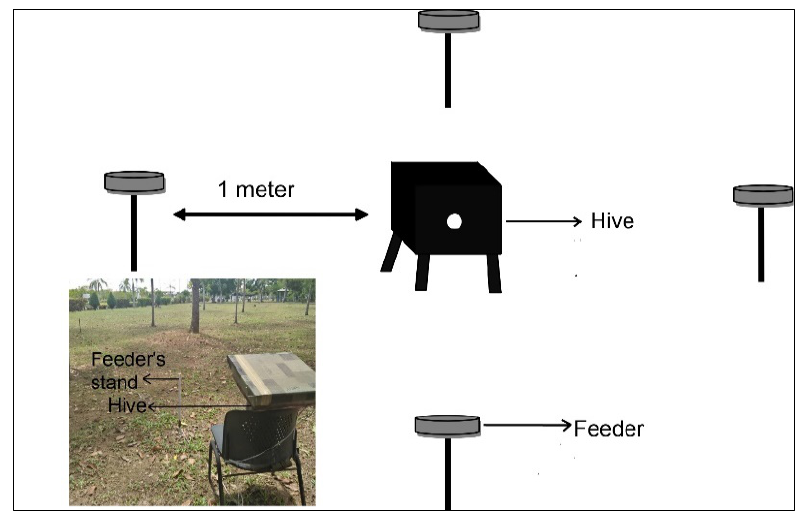
Figure 1. The experimental set-up for experiment 1. The set-up was a modified version from Ciar et al. [13]. Petri dishes contained water (0%), 15%, 35%, and 50% sugar (sucrose) concentration were placed around the colony according to the four cardinal directions: north, south, west, and east. The feeder stands were placed 1 m from the trial colony. The feeders were rotated clockwise every three hours. The white dot on the beehive represents the colony entrance (faced to the east during the actual experimental trials). Inset: the actual experimental area.